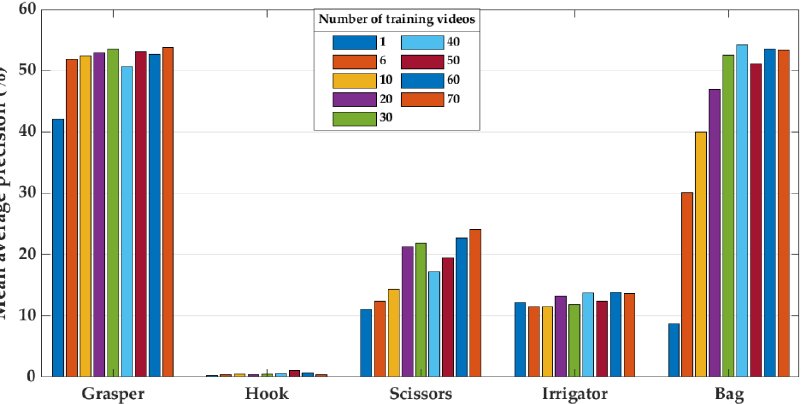
Figure 10. Model performance on the EndovisChole dataset for grasper, hook, scissors, irrigator, and bag when using increasing number of training videos.